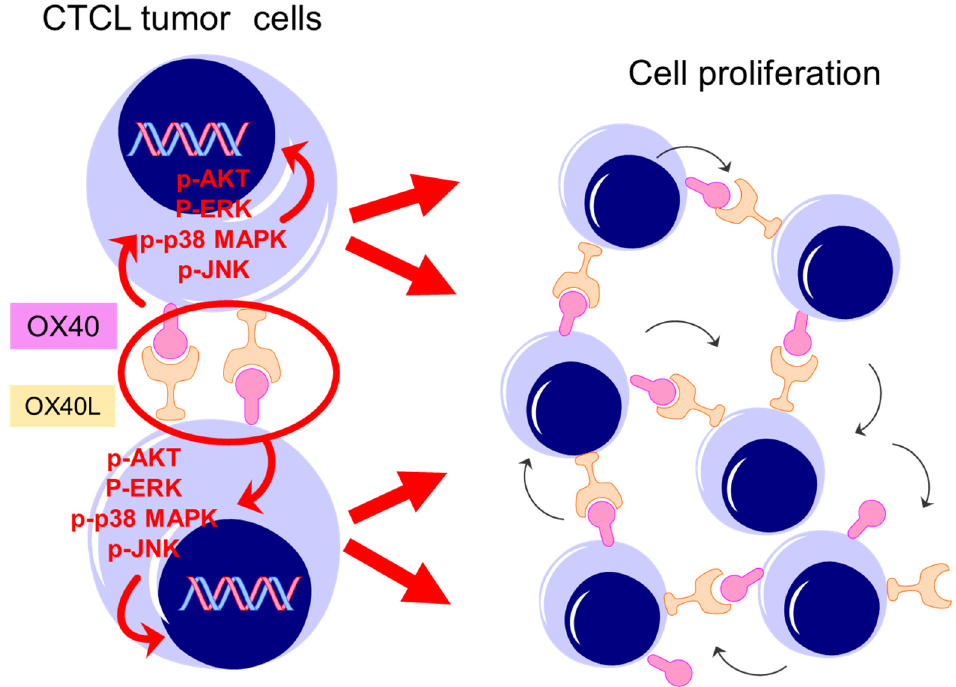
Figure 7. Schematic model of the main findings of this